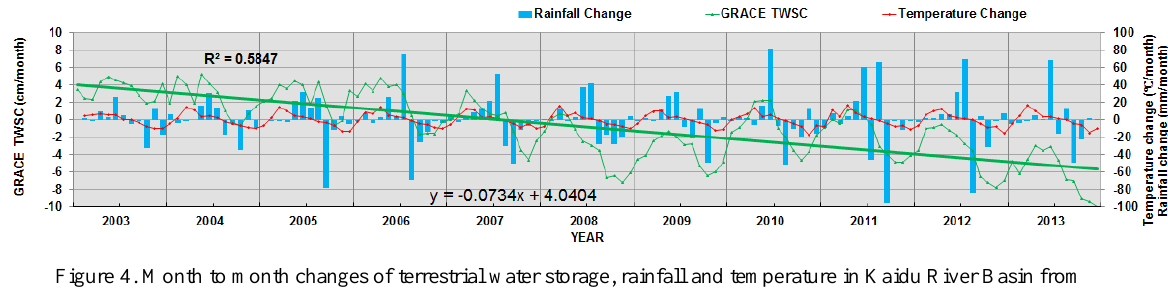
Figure 4. Month to month changes of terrestrial water storage, rainfall and temperature in Kaidu River Basin